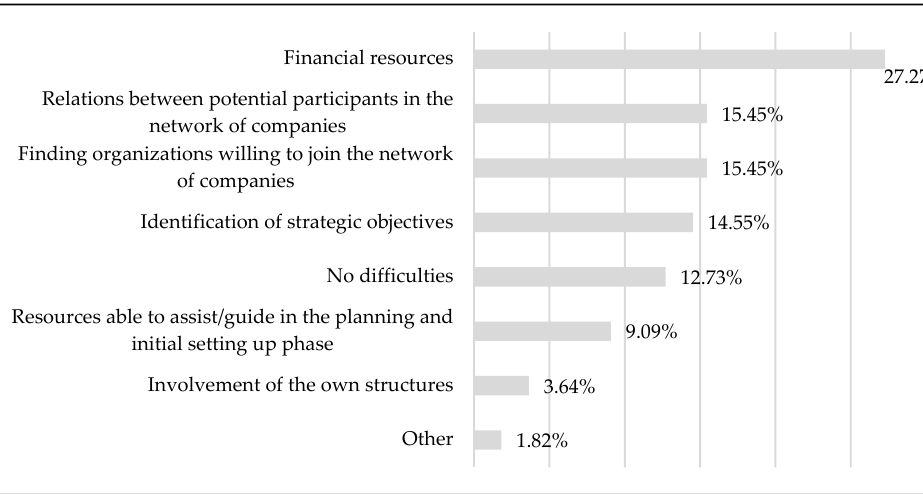
Figure 7. Difficulties to join networks. Ranking results. Source: Authors elaboration on data collected and shown in TRACES D3.1 deliverable.